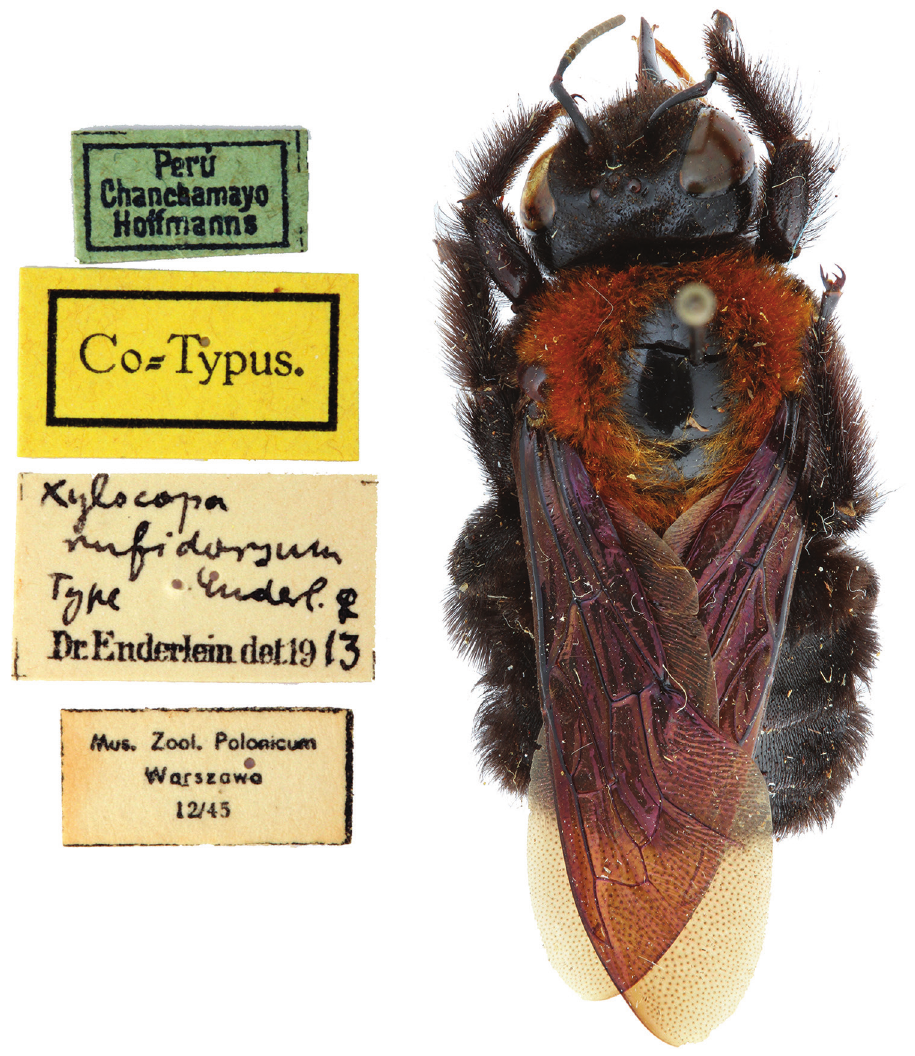
Figure 7. Dorsal habitus of the female lectotype of Xylocopa ( Neoxylocopa ) rufidorsum Enderlein.